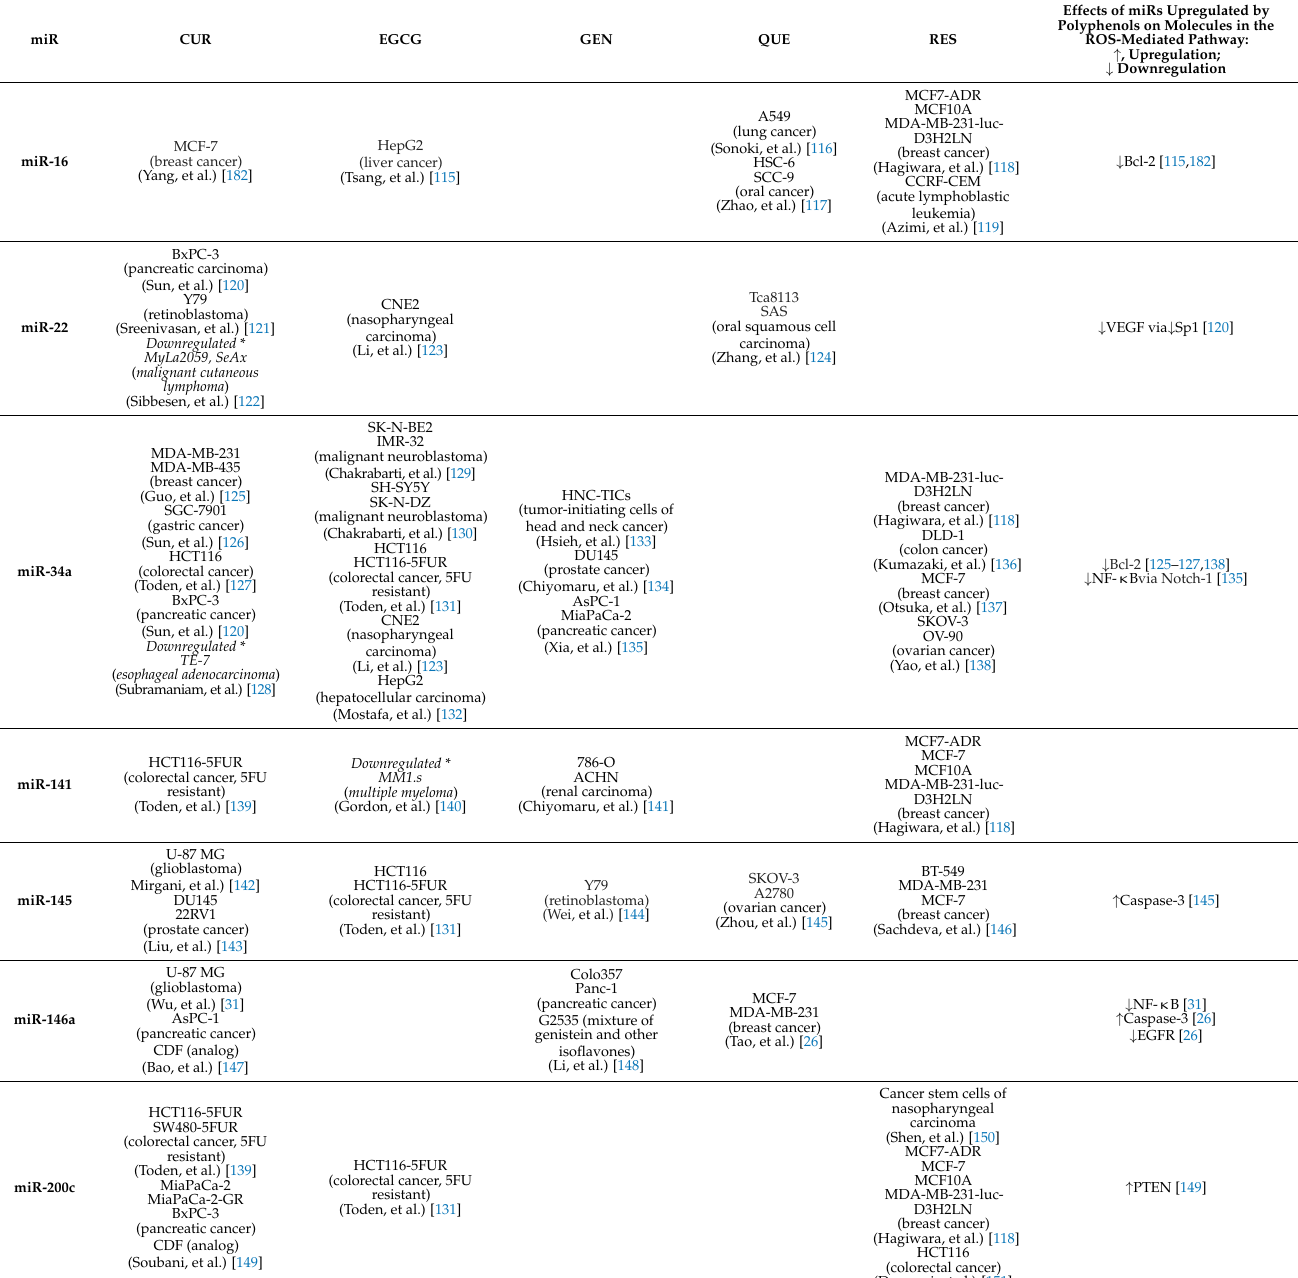
Table 4. Tumor-suppressor miRs upregulated by polyphenols, cell types examined, and effects of miR